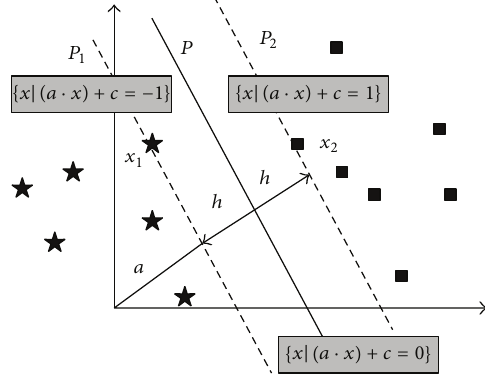
Figure 1: Hyperplane in the linearly separable